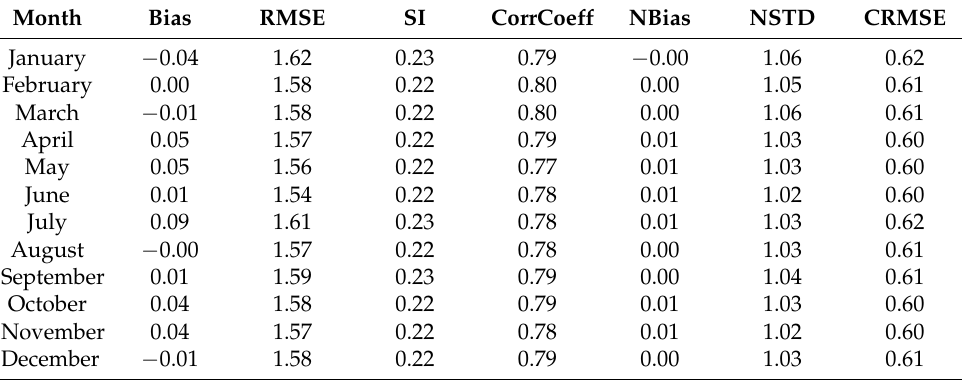
Table 2. Mean monthly variability of error measures between the two reanalyses (wind speed).